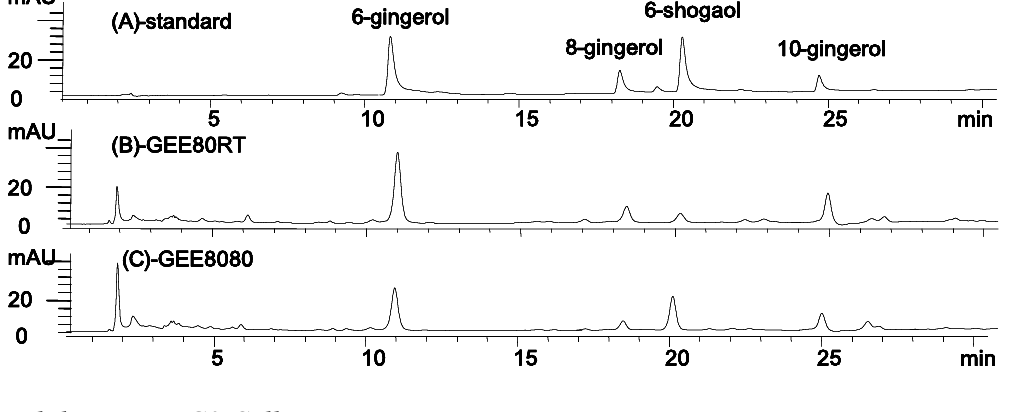
Figure 1. HPLC chromatograms of standard ginger compounds and representative ginger extracts. ( A ) standard compounds of ginger; ( B ) GEE80RT, ginger extract extracted with 95% at room temperature after drying at 80 °C; ( C ) GEE8080, ginger extract extracted with 95% ethanol at 80 °C after drying at 80